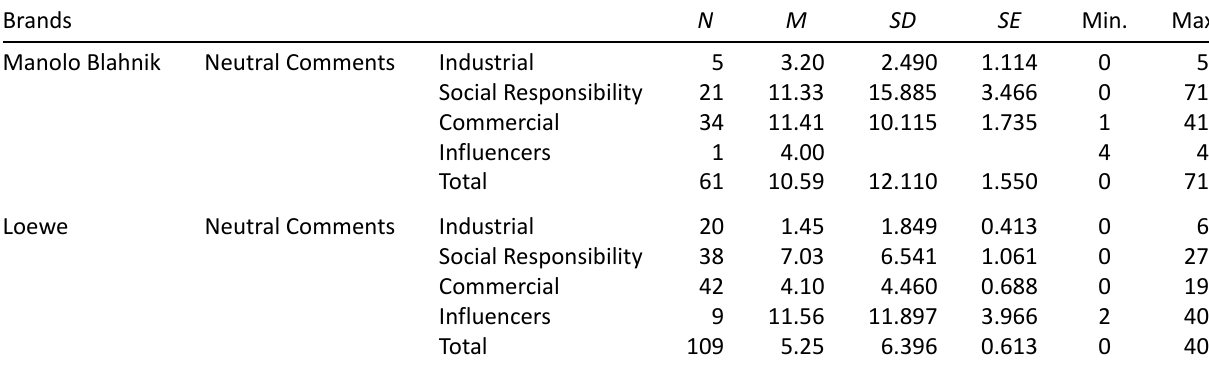
Table 6. Descriptive statistics of neutral comments generated based on brand content. Brands